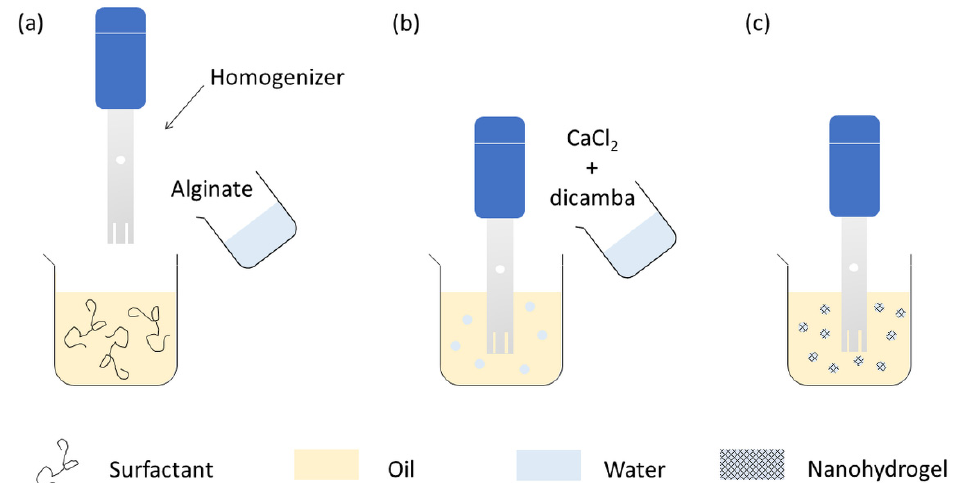
Figure 1. Experimental set-up for the synthesis of dicamba-loaded alginate nanohydrogels: ( a ) addition of the alginate solution to the oily phase and mixing with Ultra Turrax homogenizer, ( b ) addition of CaCl 2 and dicamba solution to the miniemulsion, and ( c ) nanohydrogels obtained thanks to the cross-linking of alginate droplets.